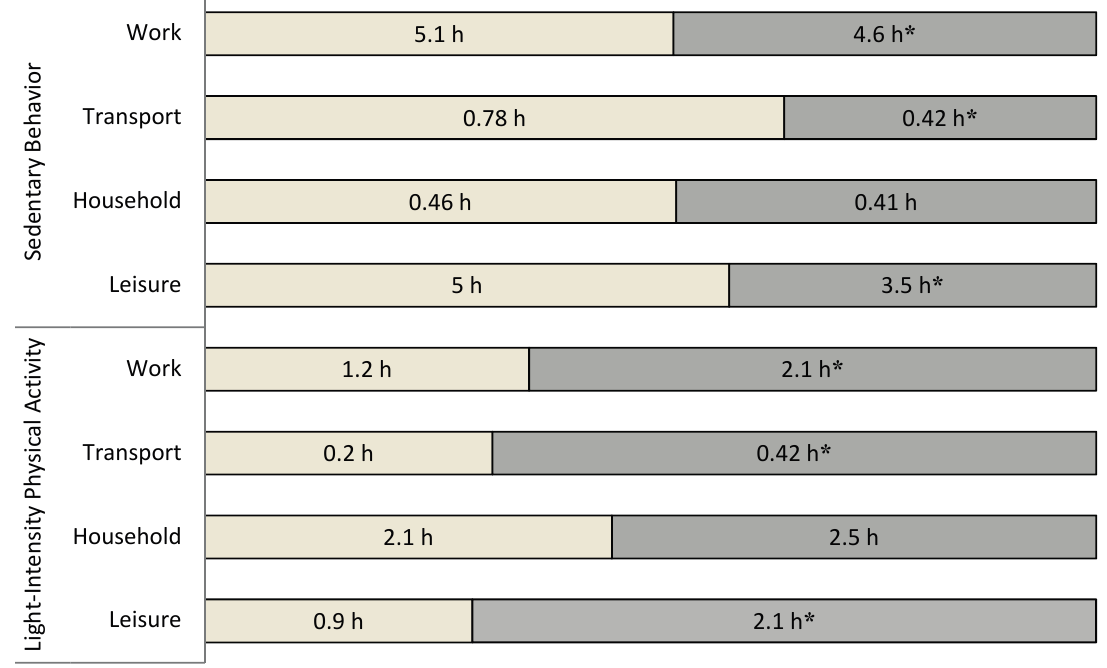
Figure 3. Time differences (h/day) spent in sedentary behavior and light-intensity physical activity across four daily life domains: work, transportation, household activities, and leisure time (based on the 7-day SLIPA Log). * p